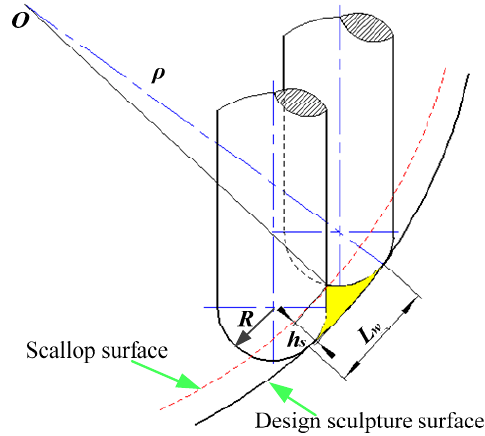
Figure 8. Calculation scheme of the scallop height.